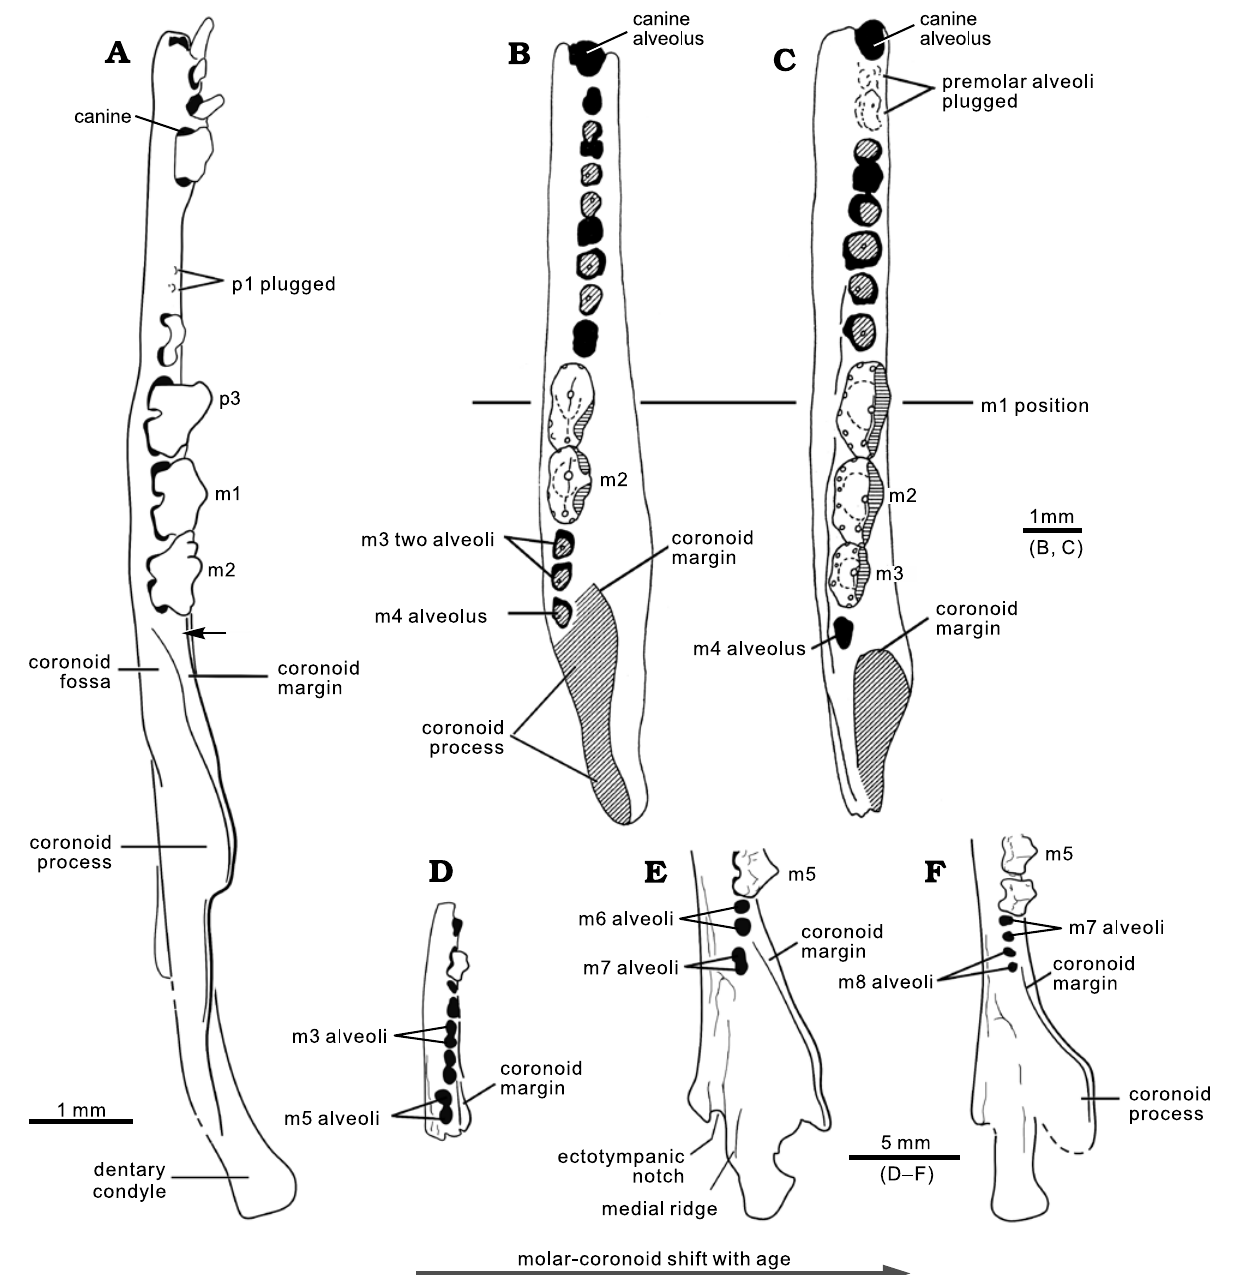
Fig. 11. Comparison of the mandible of Hadrocodium with the mandibular growth stages of Morganucodon and Docodon . A . The mammaliaform Hadrocodium wui Luo, Crompton, and Sun, 2001 (holotype, IVPP 8275) from the Lower Lufeng Formation, Lower Jurassic of Yunnan, China (arrow indicates the retro-molar space and feature of adult). B , C . Mandibular growth stages of the morganucodontan Morganucodon watsoni Kühne, 1949 (= “ Eozostrodon parvus ”) from the Lower Jurassic fissure fills of Wales (Parrington 1971); adult ( B ) and the oldest-known adult ( C ) (respectively speci- mens D60 and D120 in Parrington 1971: fig. 3). D – F . Mandibular growth stages of the docodontan Docodon victor Schultz, Bhullar, and Luo, 2019,